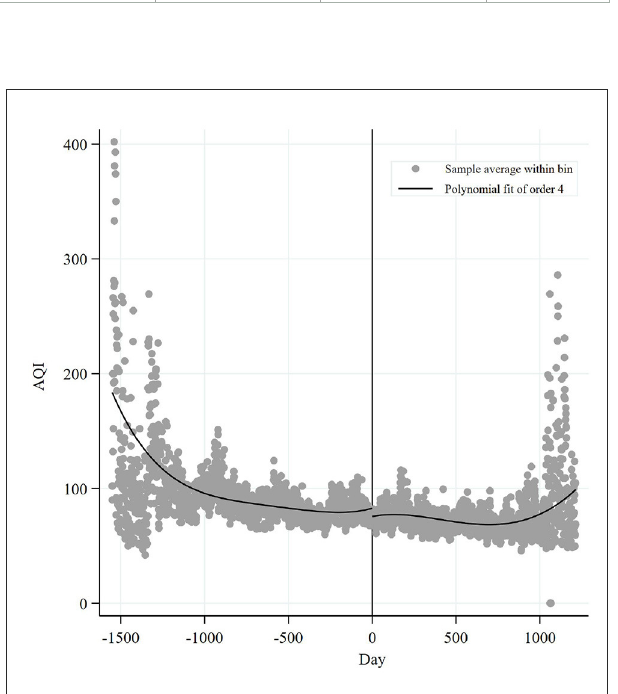
FIGURE3 AQI fitting curve before and after the entry of the CEPI